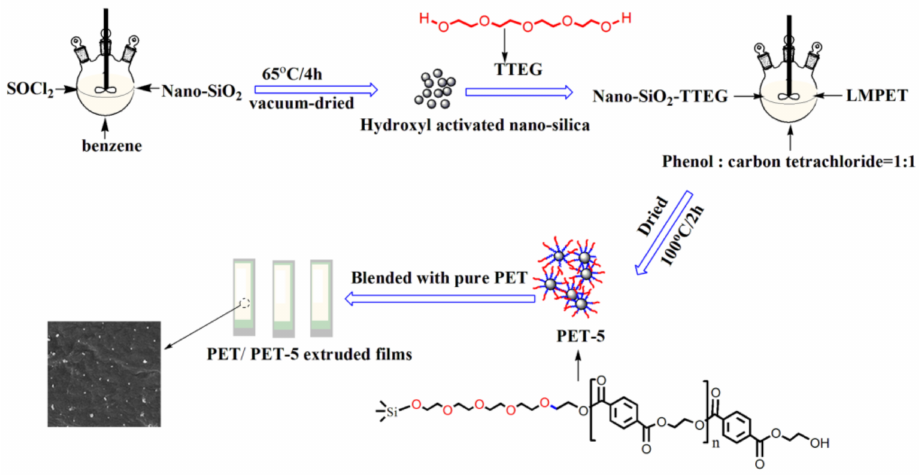
Figure 2. Scheme of interaction mechanism between PET and